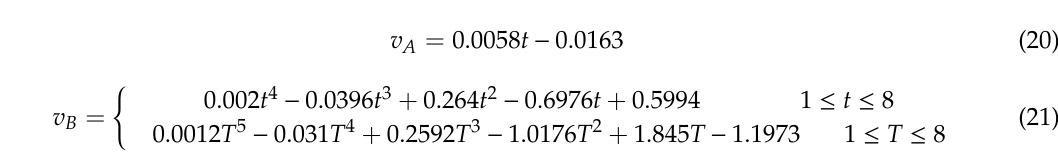
Figure 7. The comprehensive evaluation values of ecological environment benefits of land use.